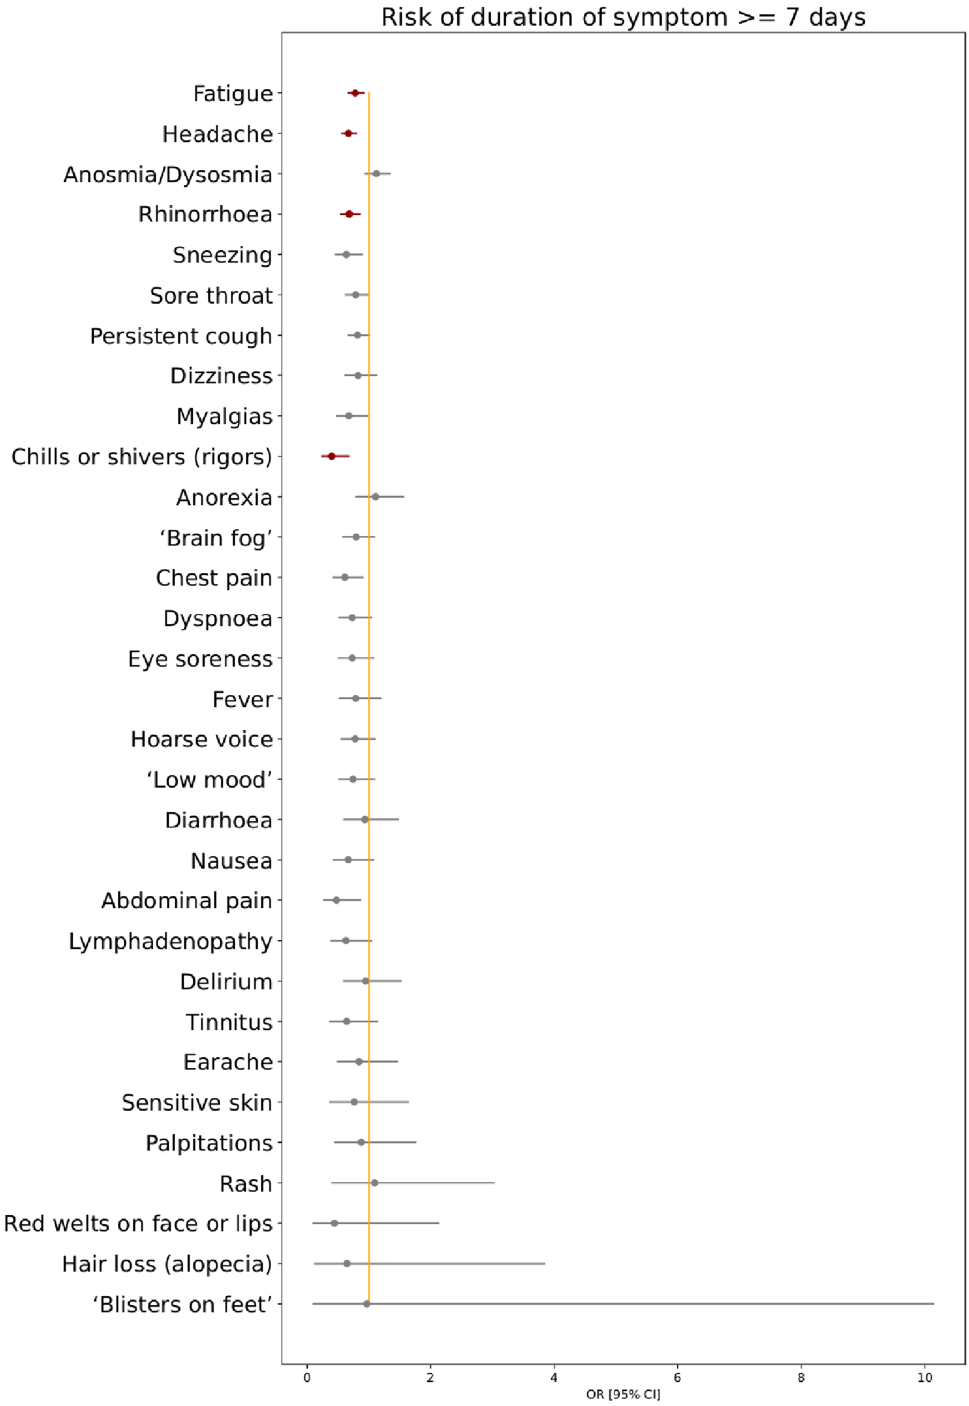
Figure 3. Odds ratios for risk of symptom duration ≥ 7 days for individuals with COVID-19 during periods of SARS-CoV-2 Delta versus Alpha variant predominance. Age, gender, and vaccination.status are included as covariates in this analysis. Red markers encode statistical significance with α-value < 0.05 (after FDR correction), whereas grey markers encode non-significant